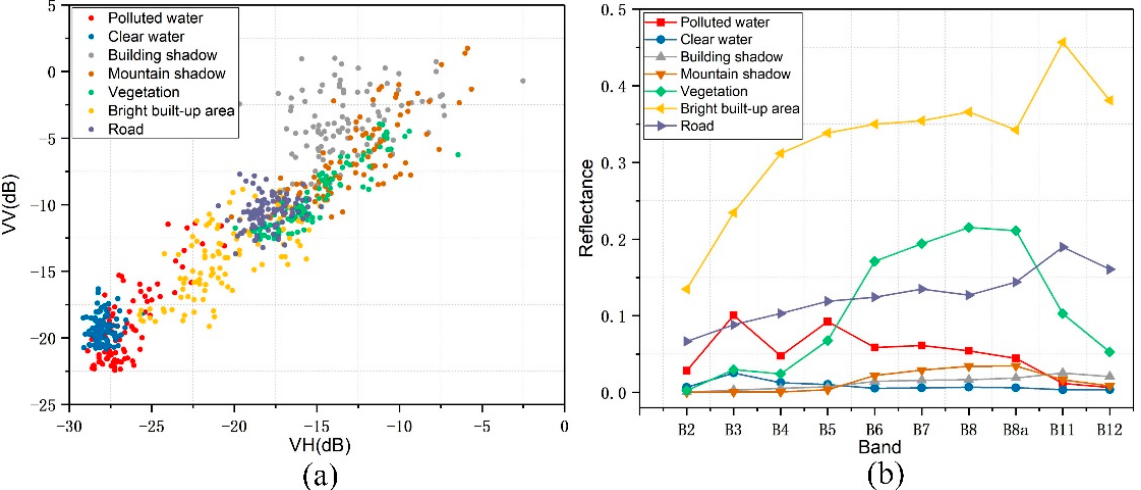
Figure 3. Feature space plots for seven land cover types sampled. ( a ) Polarization, S1 and ( b ) spectral, S2 differences.